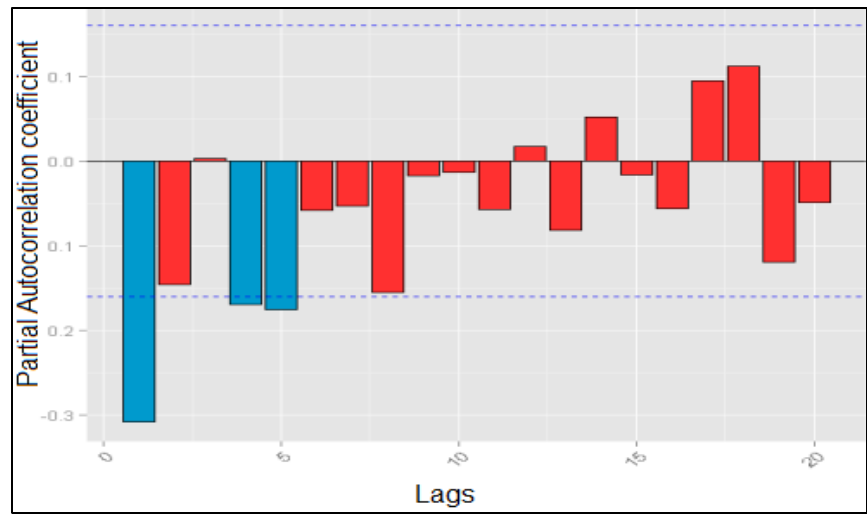
Figure 3. Graph of the partial autocorrelation function (PACF) for the differentiated and seasonally adjusted time series of electricity consumption in Paraná. Table 5. Forecast results for one step ahead, compared by the error measures MSE, MAE, MAPE, and their respective performance